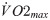
Evolution of the anaerobic energy vs the distance to the finish line.Green: horse of the 1300m, orange: horse of the 1900m, pink: horse of the 2100m. The distances are highlighted when the energy has a change of slope and the energy value at this point is indicated as well: it is at the beginning of the race when the V˙O2max is reached, and at the end of the race, when the V˙O2 starts decreasing.